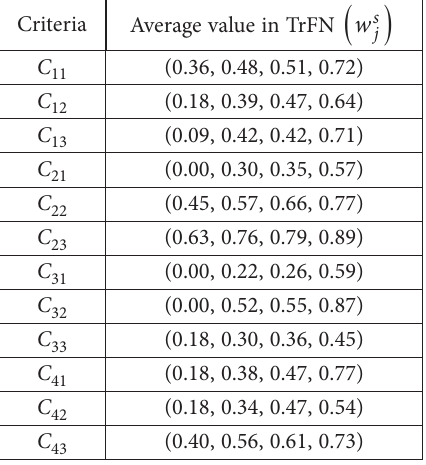
Table 7. Aggregated subjective criteria weights Criteria